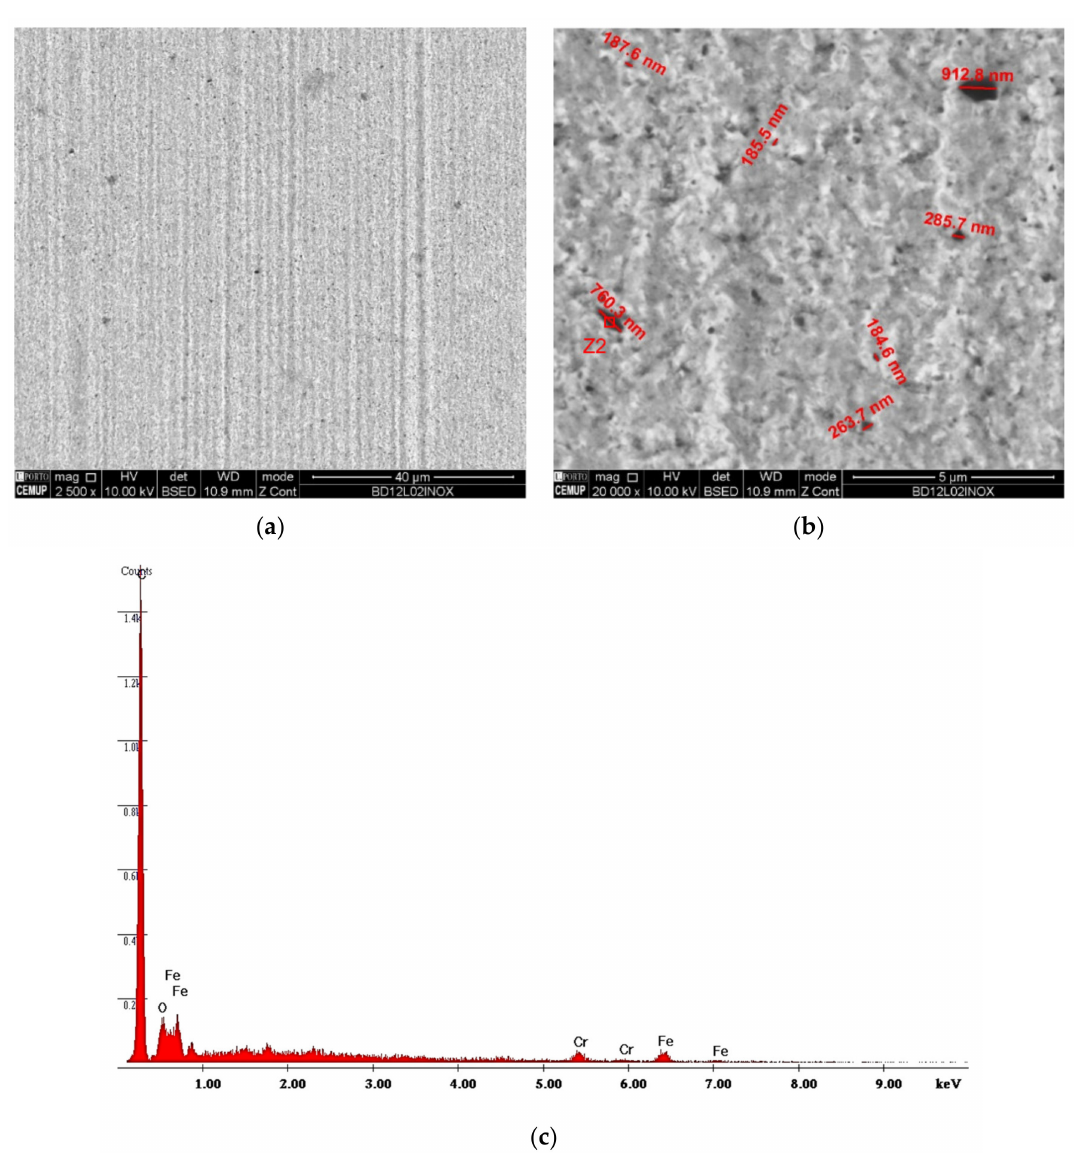
Figure 20. SEM track analysis for abrasive diamond powder (1–2 µ m) with 0.2 N load for SS AISI 304 ball: ( a ) track on the ball, ( b ) embedded diamond particle dimension, ( c ) EDS spectrum in the Z2 zone indicating diamond